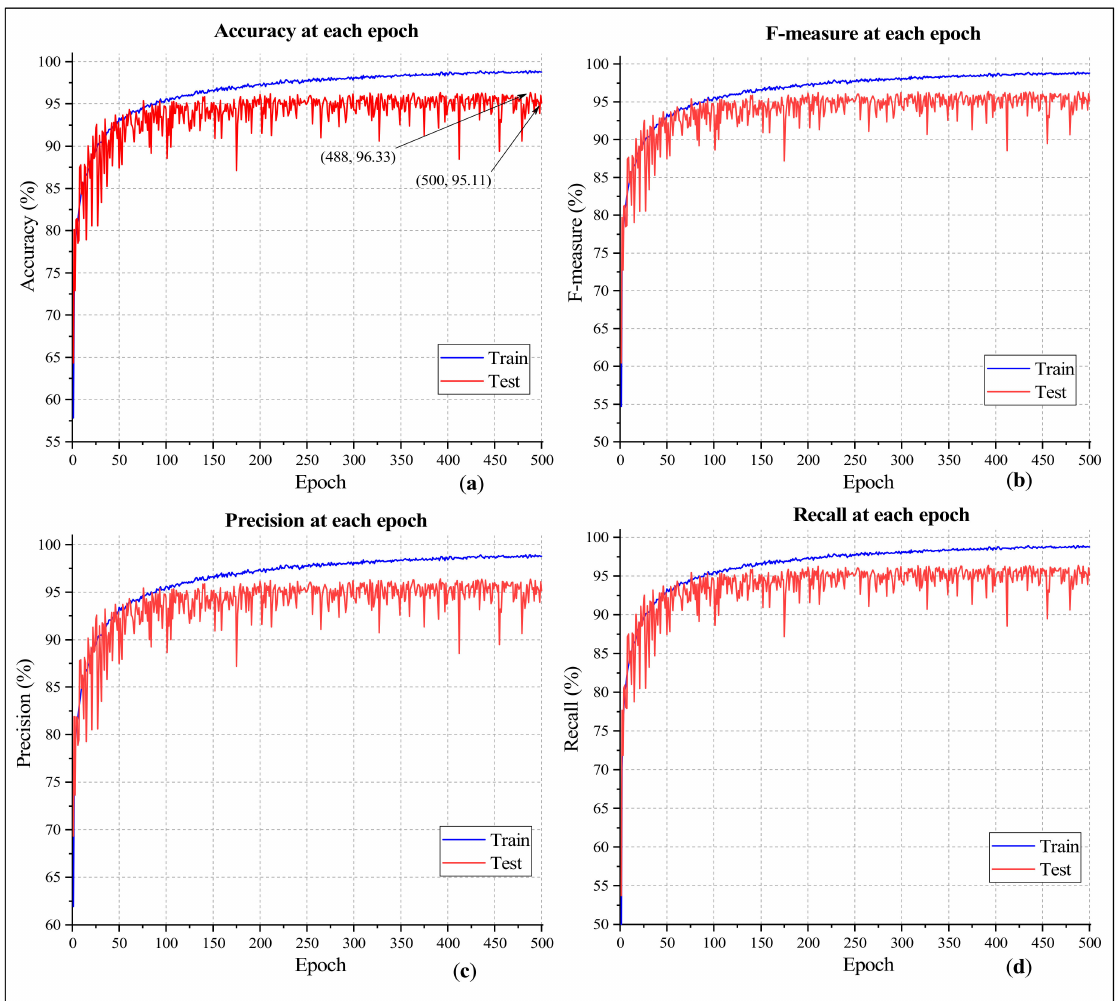
Figure 8. Classification outcome showing ( a ) accuracy, ( b ) F-measure, ( c ) precision, and ( d ) recall at each